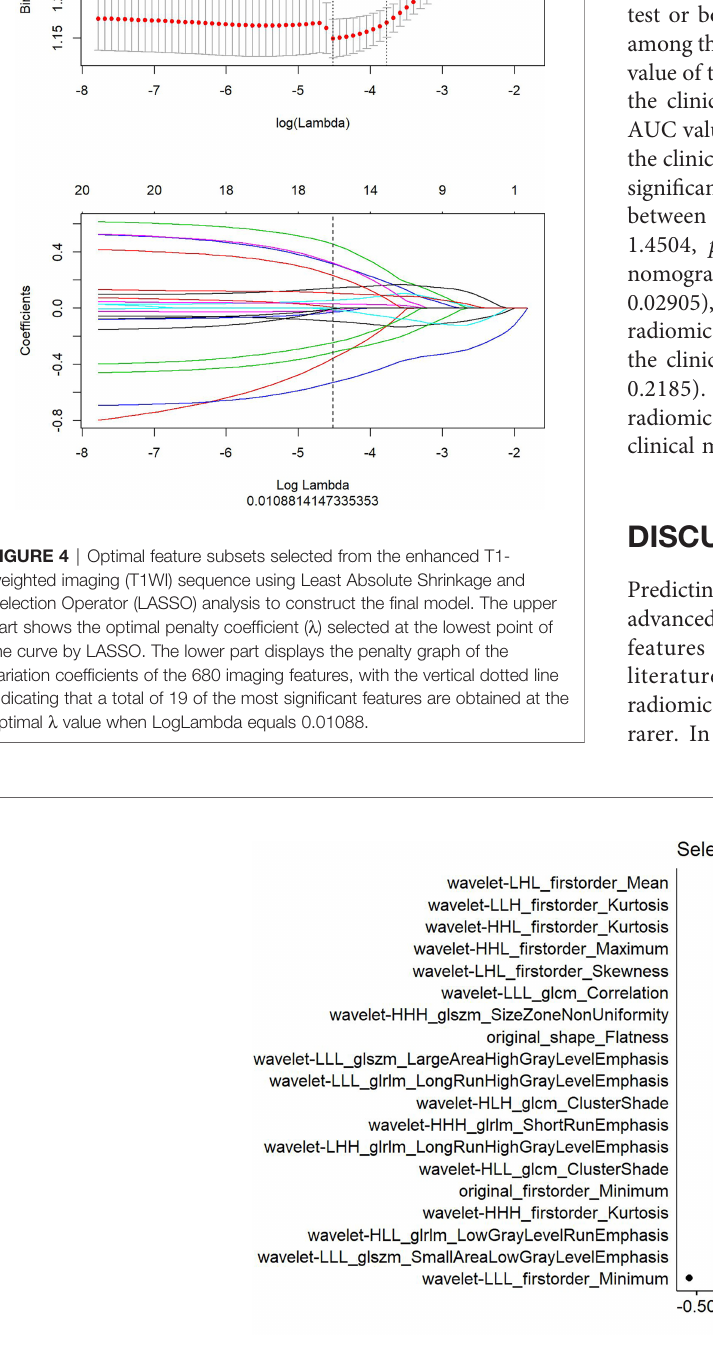
FIGURE 5 | Features selected from the enhanced T1-weighted imaging (T1WI) sequence and the weights of the corresponding features.